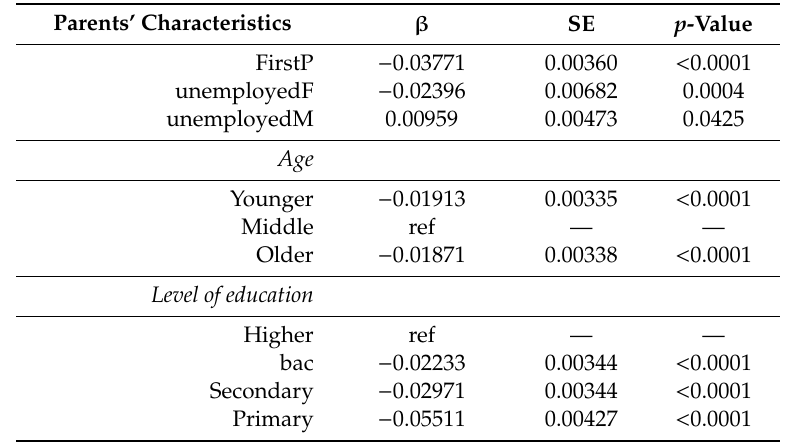
Table 3. Full-information robust maximum likelihood (MLR) estimates of the direct e ff ects of parents’ characteristics on Favorable Fetal Growth Conditions (FFGC) from Model 3 (as described in Figure